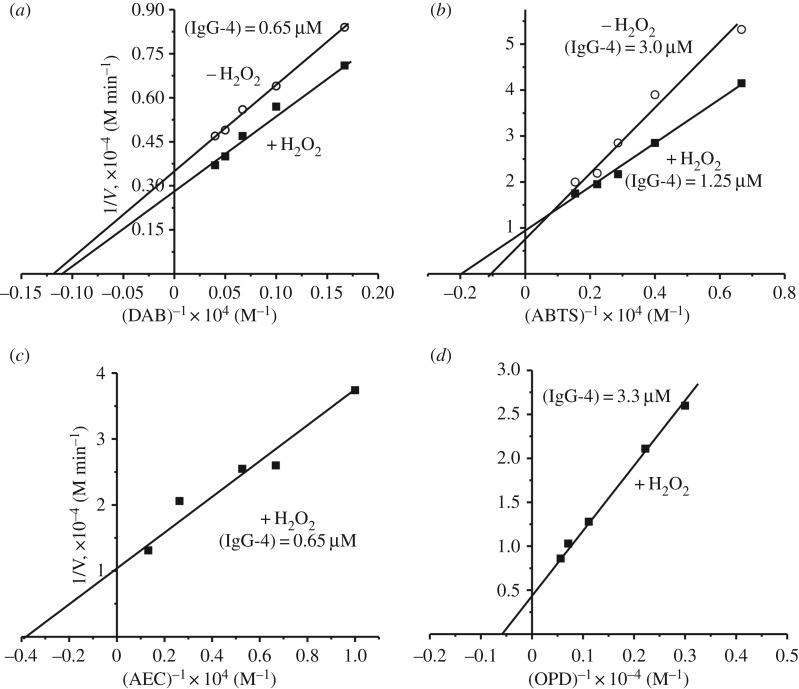
Evaluation of the Km and Vmax values for hydrolysis of several substrates by IgG-4 using Lineweaver–Burk plots in the presence and/or in the absence of H2O2: DAB (a), ATBS (b), AEC (c) and OPD (d).